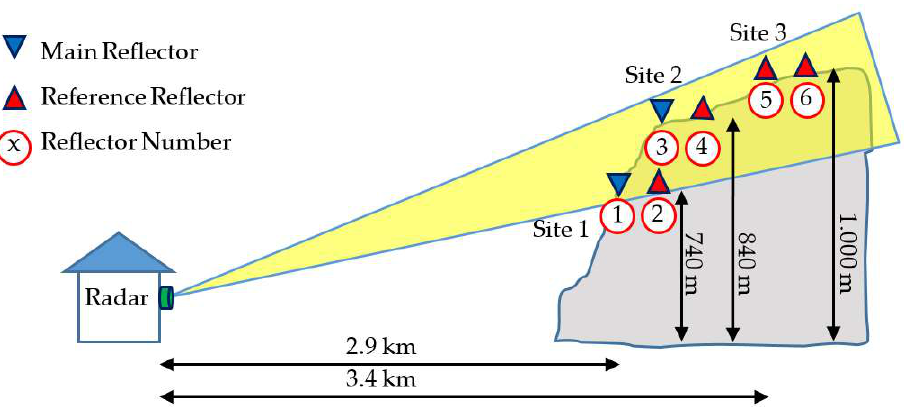
Figure 2. Illustration of the measurement setup at Hegguraksla. There are three sites in the mountain with two reflectors at each. The numbering of the six reflectors is indicated below each reflector. The radar is located roughly 3 km from the mountain. The triangular corner reflectors are located from 740 to 1000 m AMSL.